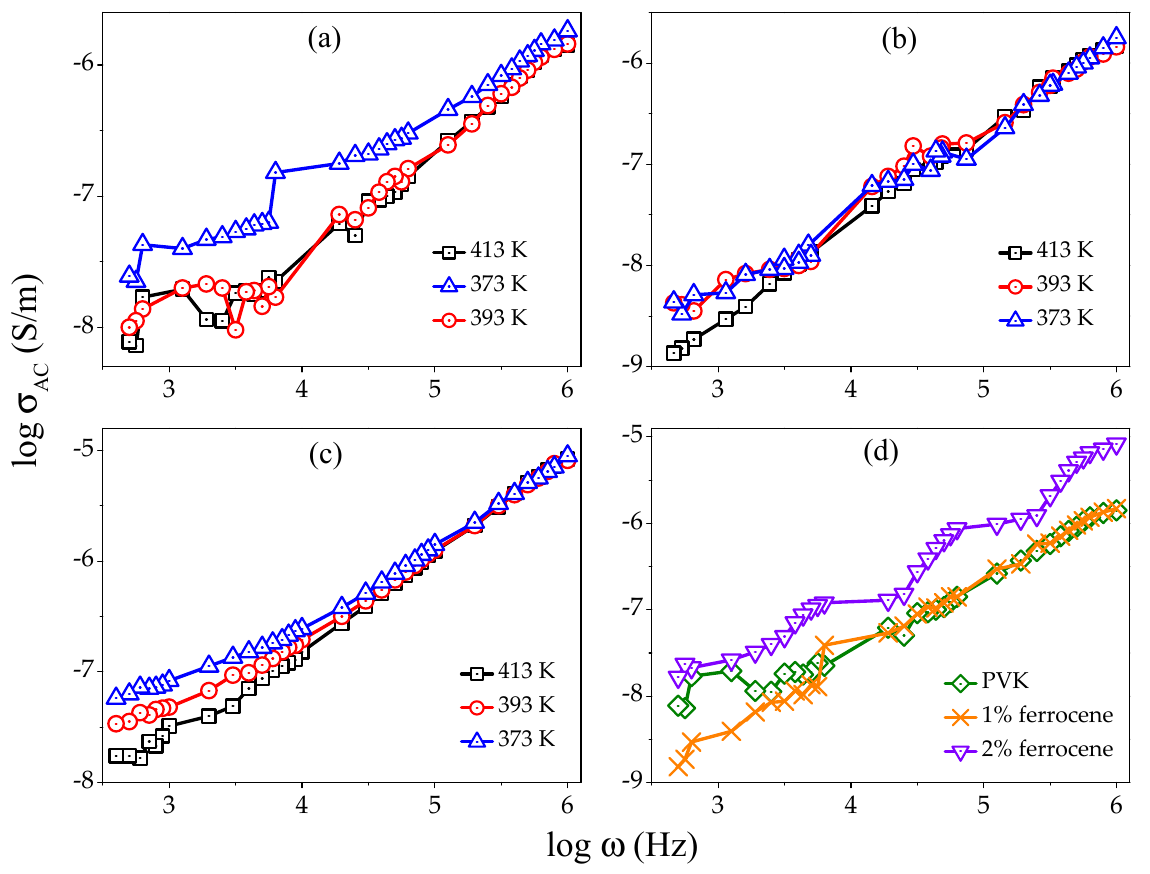
Figure 6. Variation of ac-conductivity as function of frequency for ( a ) pure PVK, ( b ) 1% ferrocene doped PVK, ( c ) 2% ferrocene doped PVK, and ( d ) comparison of AC conductivity of PVK and doped PVK at